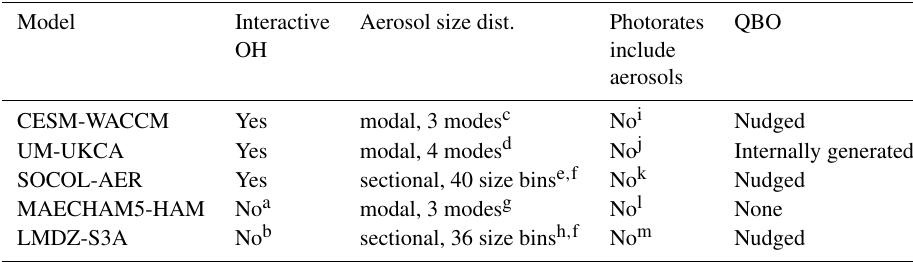
Table 2. Physics and chemistry differences of the interactive aerosol models. Model